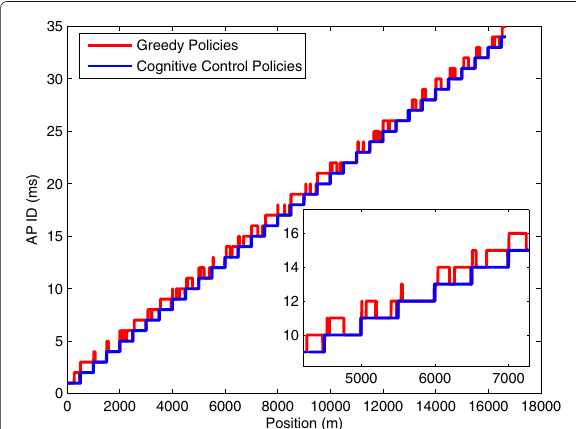
Fig. 14 Handoff decisions under greedy policies and cognitive control policies